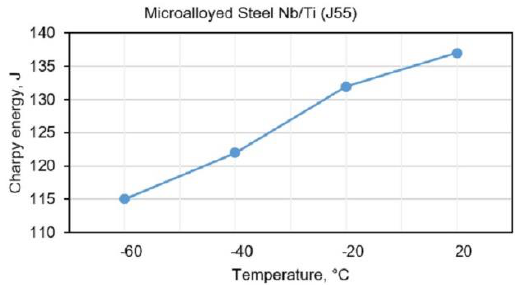
Figure 2. Impact toughness of BM Nb/Ti (J55) at different temperatures.